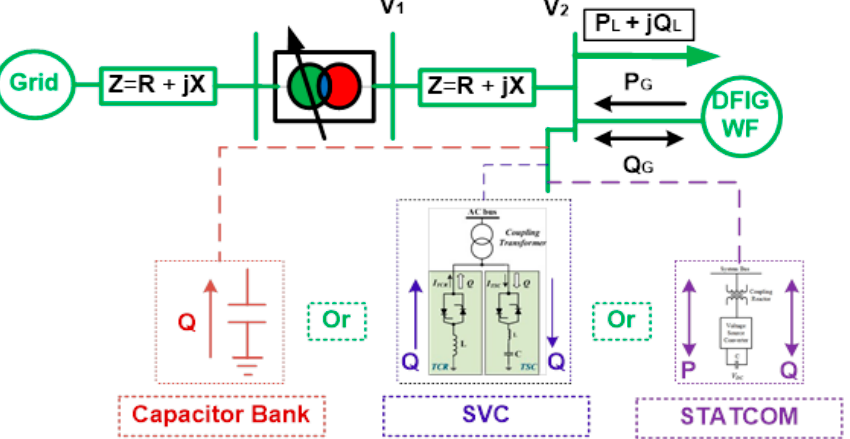
Figure A2. Schematic / connection diagram of capacitor bank, SVC, and STATCOM in test system.